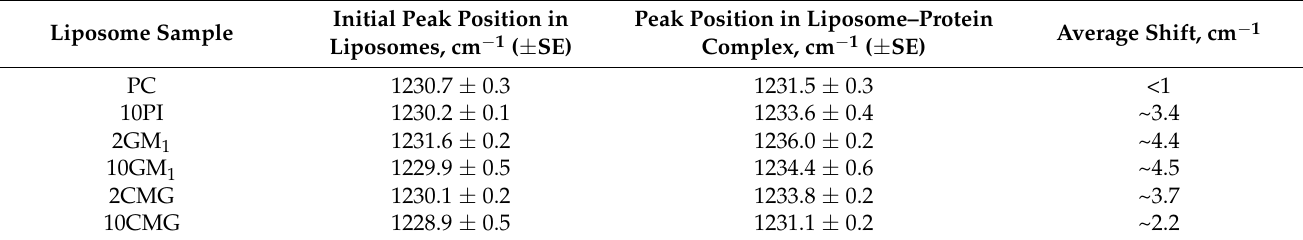
Table 2. Average PO 2 − group peak positions before and after albumin addition.